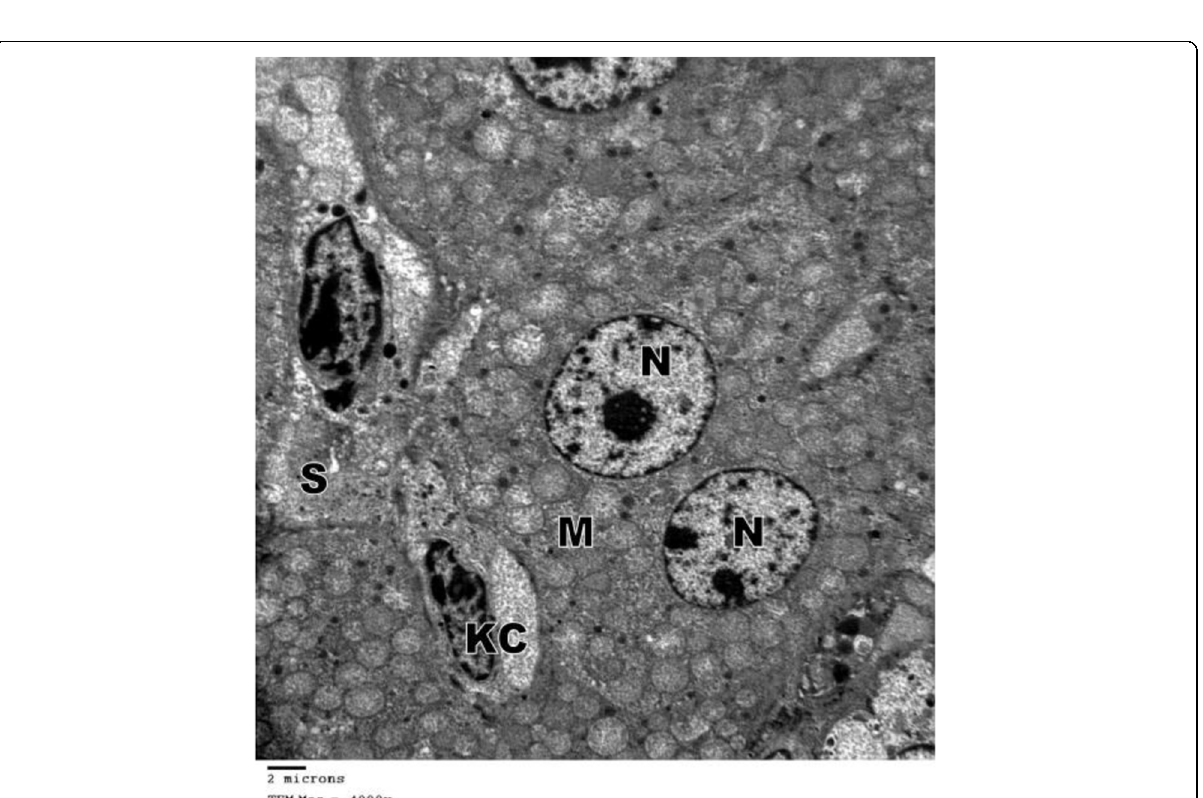
Fig. 16 An electron micrograph of a hepatocyte of treated mouse with Tamiflu (16 mg/kg b.wt.) for 10 days illustrating, binucleated (N) hepatocyte studded with numerous mitochondria (M), sinusoids (S), and Kupffer cell (KC). (×